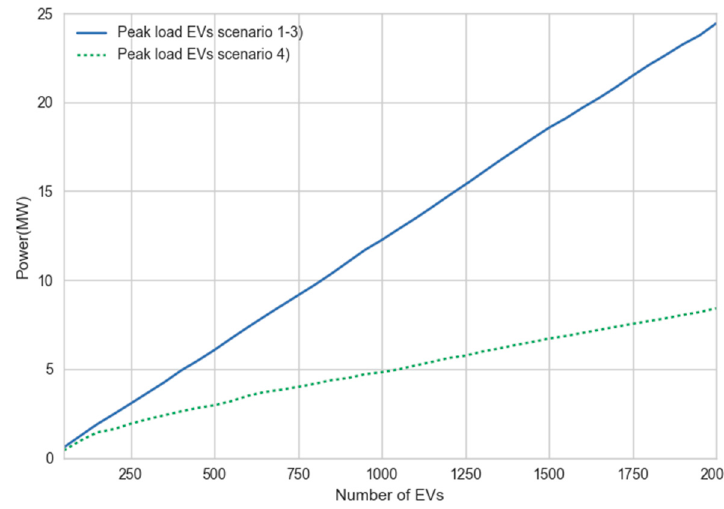
Figure 16. The maximum peak load of the EVs for both Scenarios 1–3 (no smart charging) and Scenario 4 (smart charging). Energies 2018 , 11 , 122 19 of 29